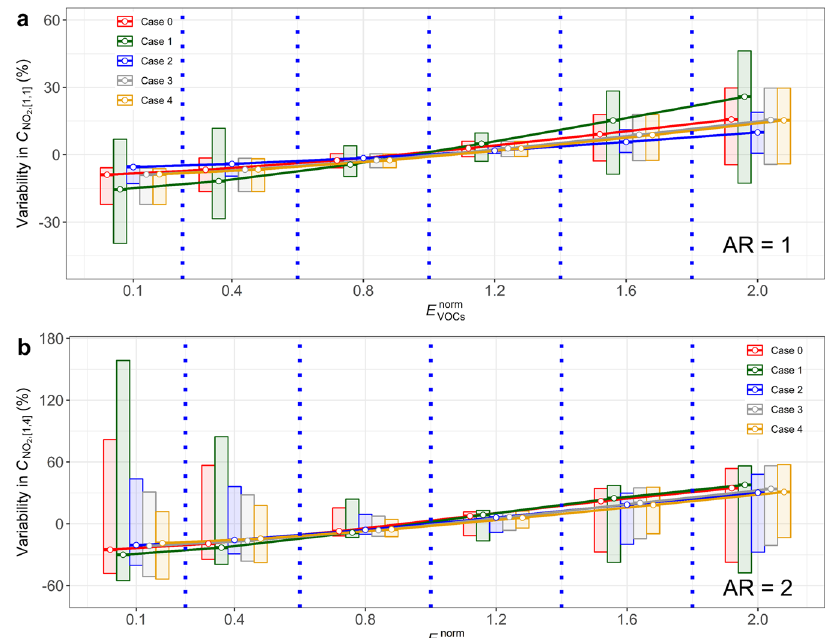
Fig. 4 The NO 2 variability under different emission scenarios. The variability in the mixing-ratio of NO 2 (%) under different normalised NO x emissions ( E norm ), VOC emissions ( E norm ), and primary NO 2 fractions ( f NO ) in regular ( a ) and deep ( b ) street canyons, respectively. Each area NO x VOCs 2 divided by a vertical blue dotted line represents one VOC emission scenario, as labelled. The points and solid lines represent the variability in ¼ 2 , f = NO 2 for the intense emission condition (IEC) on a putative perfect AR = 1 “ Marylebone Road ” ( E norm NO 2 NO x